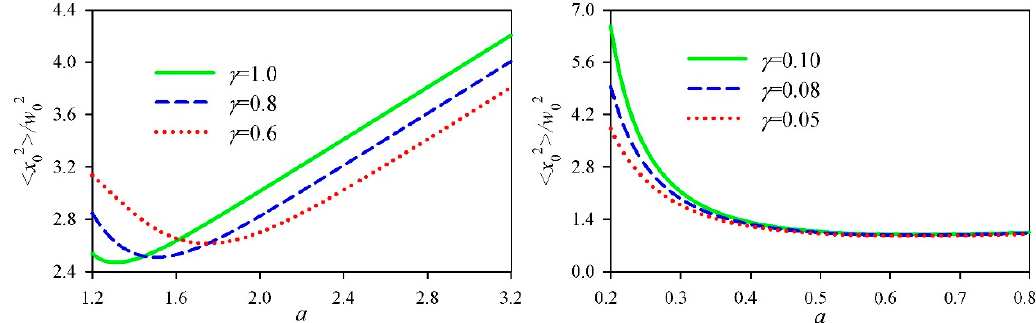
Figure 5. By giving the cosh parameter γ , the square of the beam waist in the x -direction of the cosh-Airy beam as a function of the decay factor a is shown.